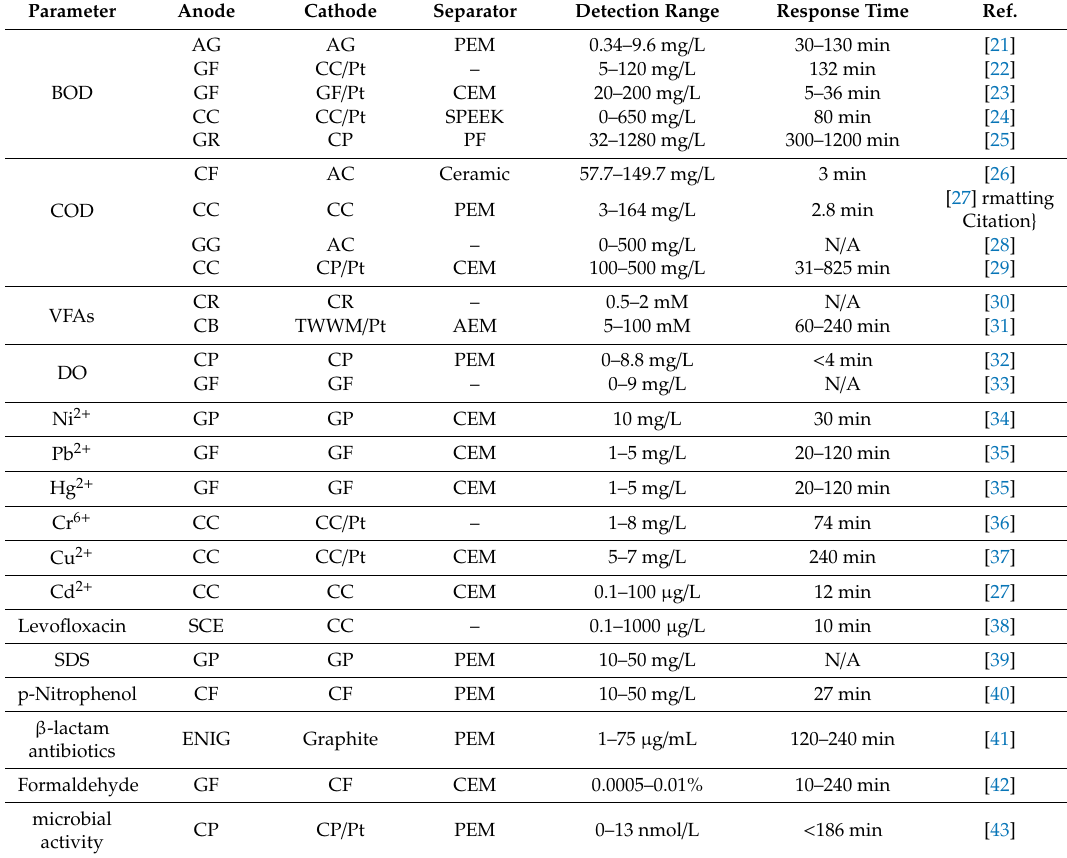
Table 1. Summary of analytical performance of MFC-based